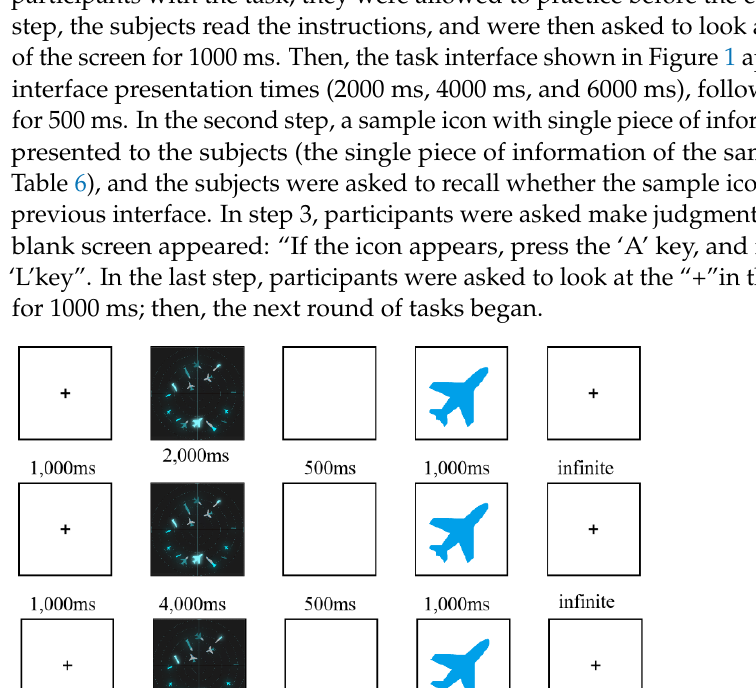
Table 5. Types of experimental interfaces.